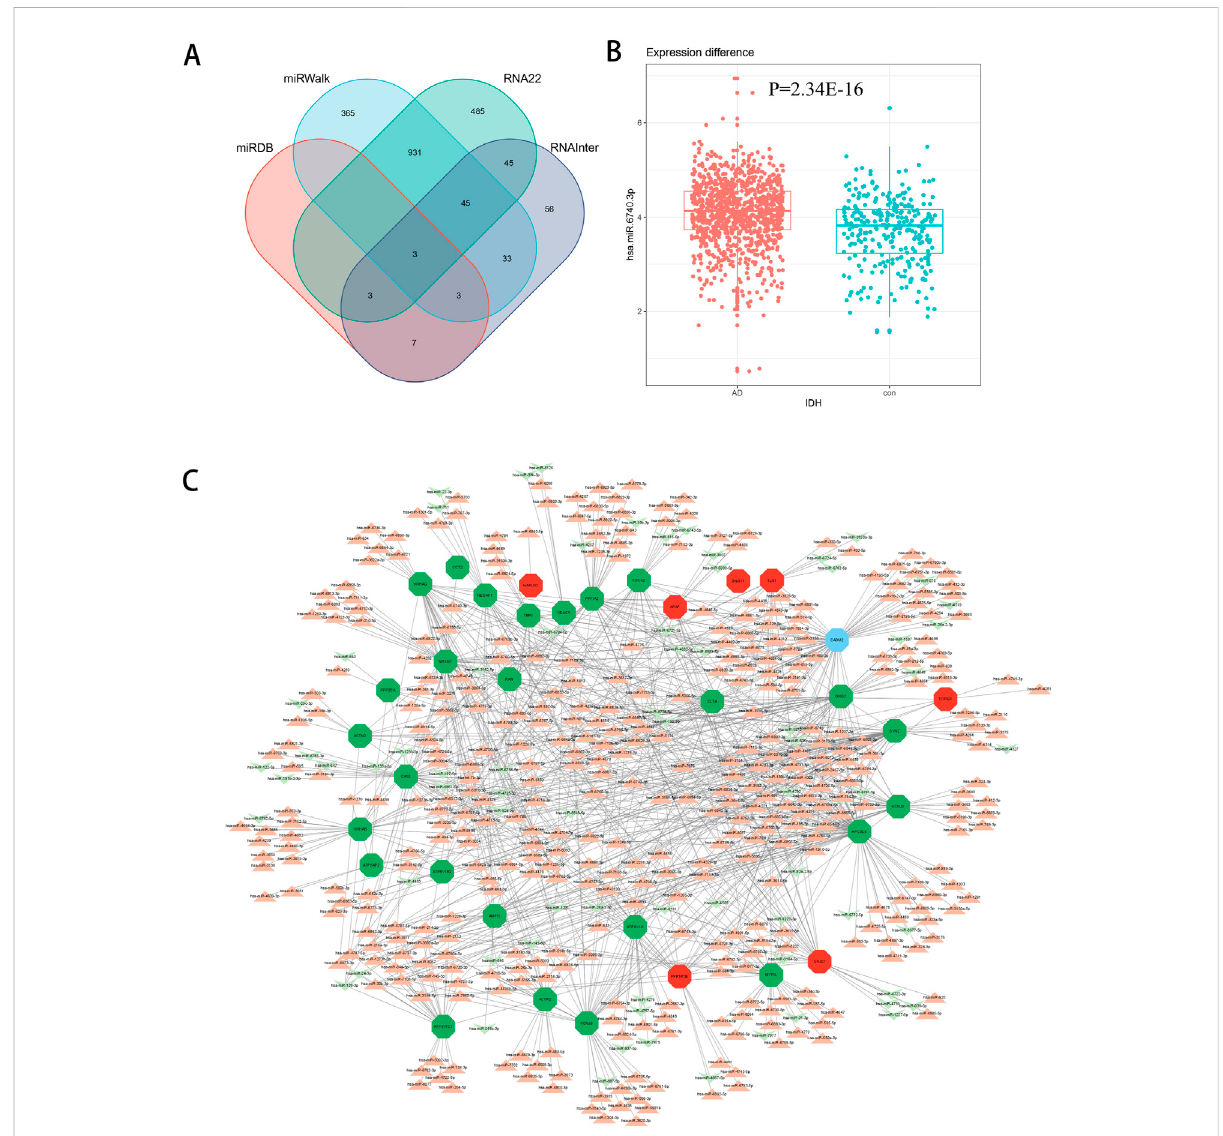
FIGURE 5 The mRNA-miRNA interaction network. (A) Four databases — miRDB, miRWalk, RNA22, and RNAInter — were combined for CCT2-targeting miRNAprediction. (B) Theboxplotdemonstratestheexpressionlevel ofmiR-6740 – 3pintheserumsamples(GSE120584)(logFC=0.38540845, p = 2.34E-16). (C) The interaction network presents the hub genes and their corresponding miRNA, with octagon nodes representing genes and other shapes representing miRNA. Upregulation is indicated in red; downregulation is indicated in